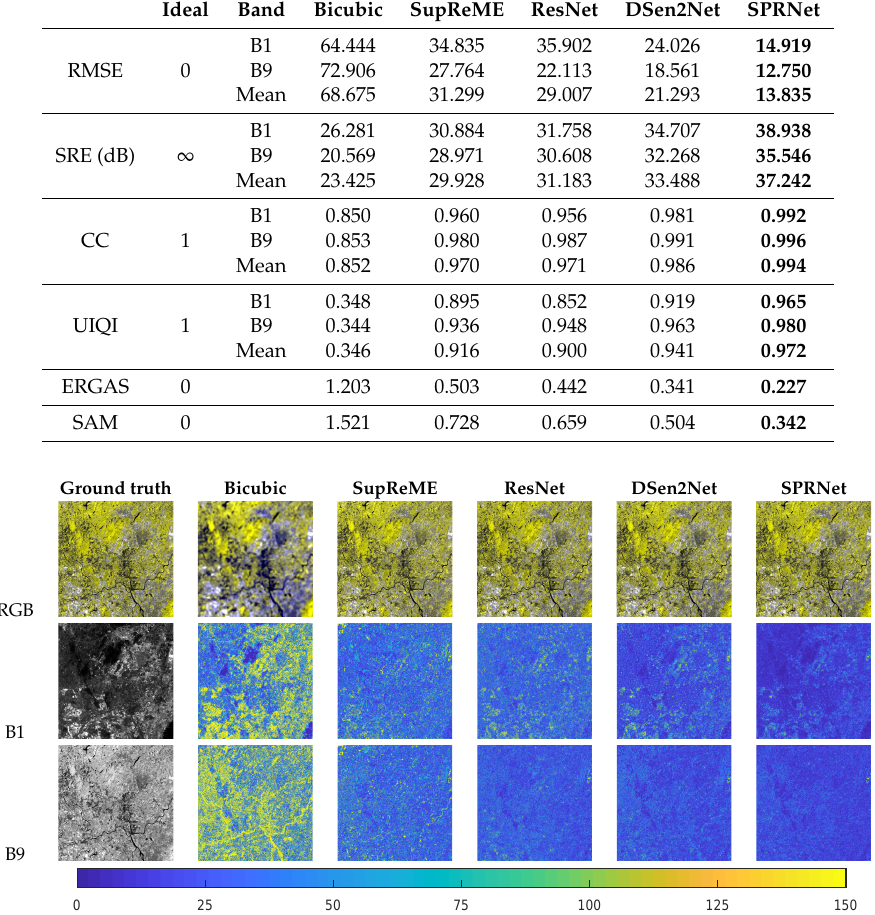
Figure 7. Absolute differences between ground truth and sharpening results on site 1 at lower scale (input 360 m output 60 m).